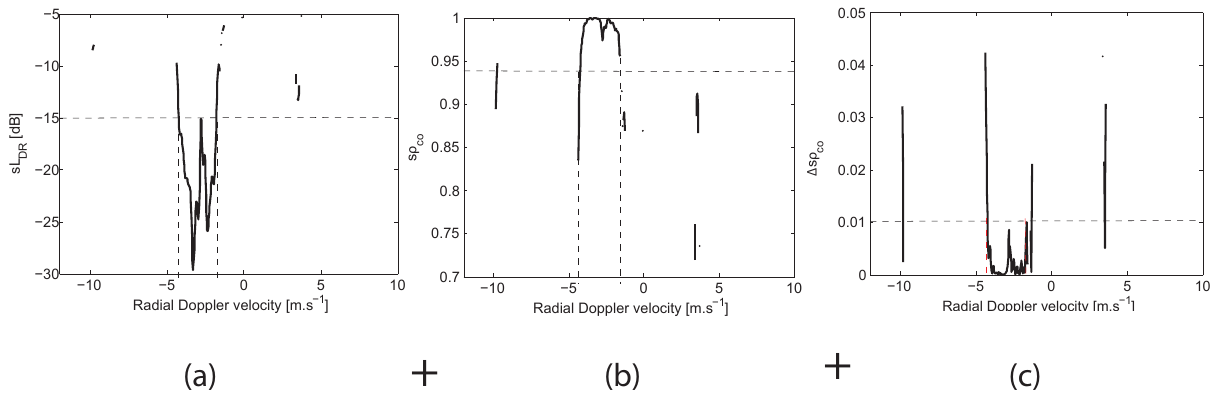
Fig. 4. Additional clipping performed on (a) sL DR,V (v) (at 15dB), (b) sρ co (v) (at 0.94) and (c) 1sρ co (v) (at 0.1). This additional clipping gives the opportunity to constrain the Doppler velocity window (from − 4ms − 1 to − 1.8ms − 1 in this example).